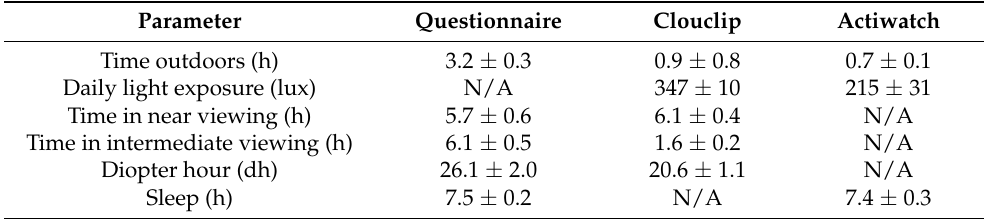
Figure 2. ( a ) Time outdoors (hours), ( b ) daily light exposure (lux), ( c ) near viewing (hours), ( d ) in- termediate viewing (hours), ( e ) diopter hours, and ( f ) sleep duration on weekdays (filled bars) and Table 2. Mean daily time outdoors, light exposure, diopter hours, near and intermediate viewing, weekend days (open bars) derived from the questionnaire, Clouclip, and Actiwatch; asterisks (*) and sleep duration are shown for the questionnaire, Clouclip, and Actiwatch. represent statistically significant differences determined by repeated measures ANOVAs, * p < 0.05, Parameter Questionnaire Clouclip Actiwatch ** p < 0.001. Time outdoors (h)